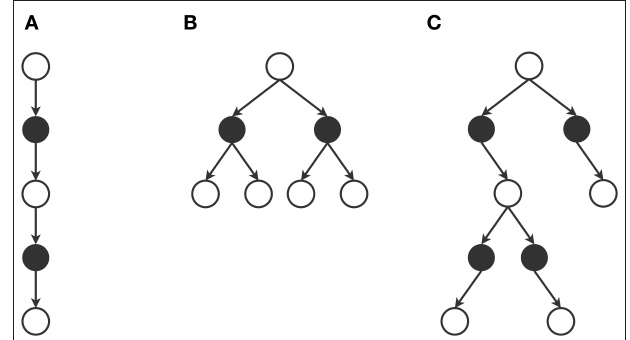
FIGURE 6 | Example local solution patterns. (A) Local solution consisting of a single trial with depth 2. Total queries to the MDP = 2. Example: two-step temporal difference learning. (B) Local solution consisting of four trial with depth 1. Total queries to the MDP = 4. Example: value iteration. (C) Local solution consisting of three trials, one with depth 1 and two with depth 2. Total queries to the MDP = 4. Example: Monte Carlo Tree